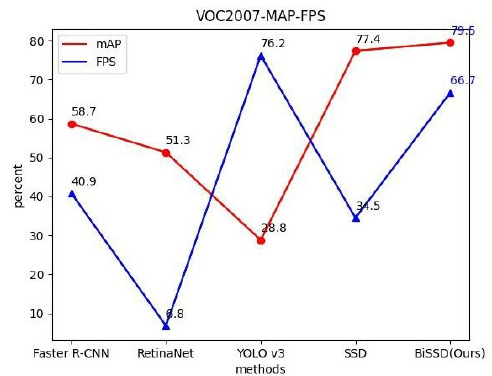
Figure 6. MAP index comparison of VOC2007 data set test.